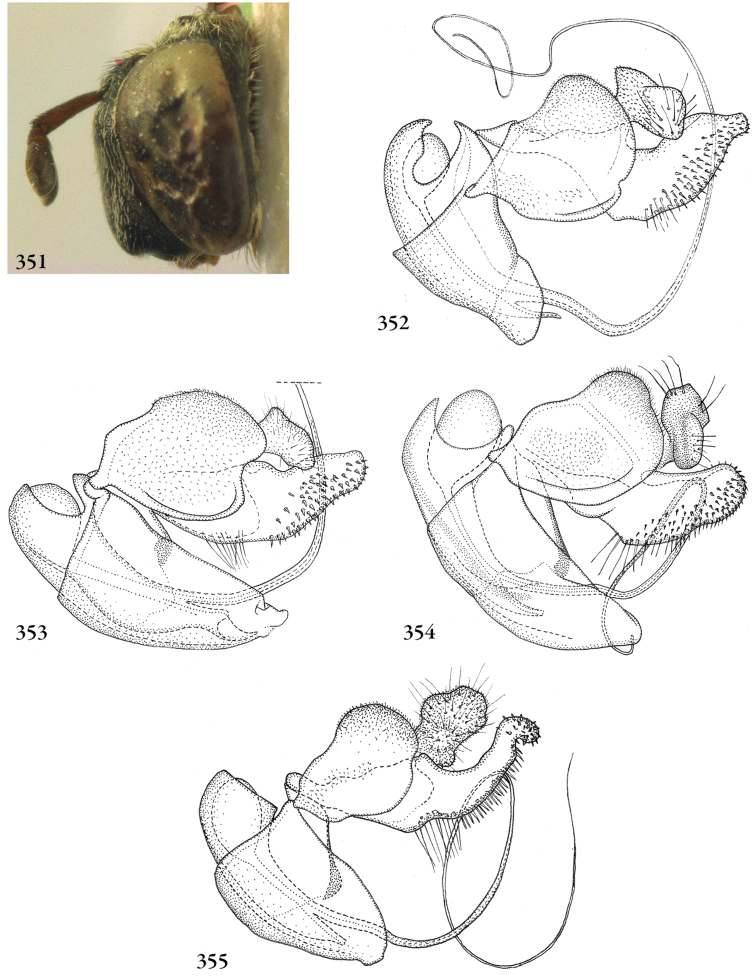
351
Rhopalosyrphus (s.l.) oreokawensis male (holotype), head lateral 352–355
Rhopalosyrphus, male genitalia: 352
Rhopalosyrphus ecuadoriensis
353
Rhopalosyrphus abnormoides
354
Rhopalosyrphus cerioides
355
Rhopalosyrphus oreokawensis.